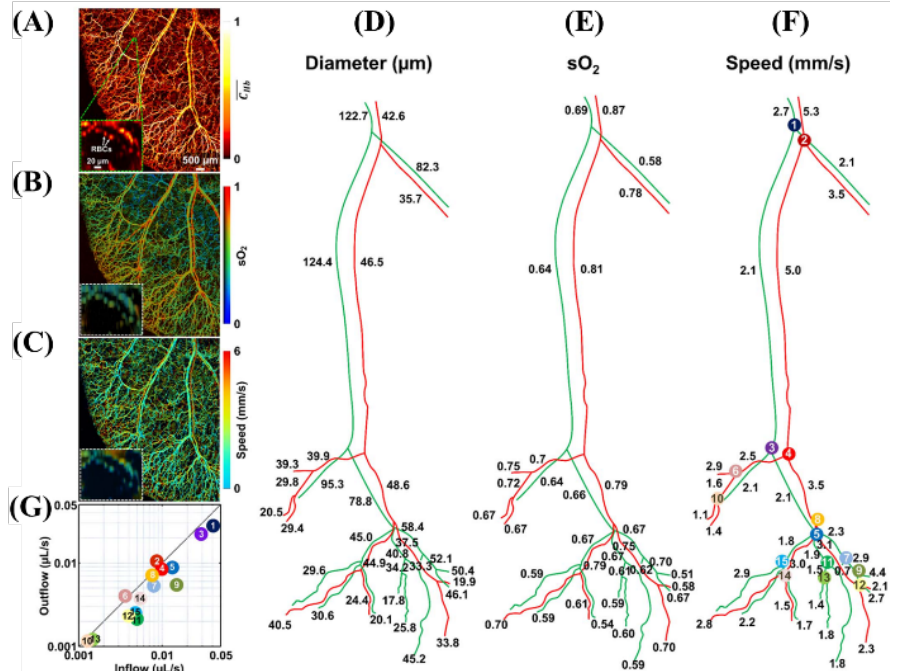
Figure 22. Simultaneous PAM of ( A ) vascular anatomy, ( B ) oxygen saturation of hemoglobin ( S O 2 ), and ( C ) blood flow speed in a nude mouse ear in vivo. Vessel segmentation reveals dynamic changes in ( D ) vessel diameter, ( E ) S O 2 , and ( F ) flow speed. ( G ) Conservation of the volumetric inflow and outflow rates at each bifurcation. Reprinted from Ning et al., Opt. Lett., 2015, 40, 6: 910–913 [39], with permission of the Optical Society of America.